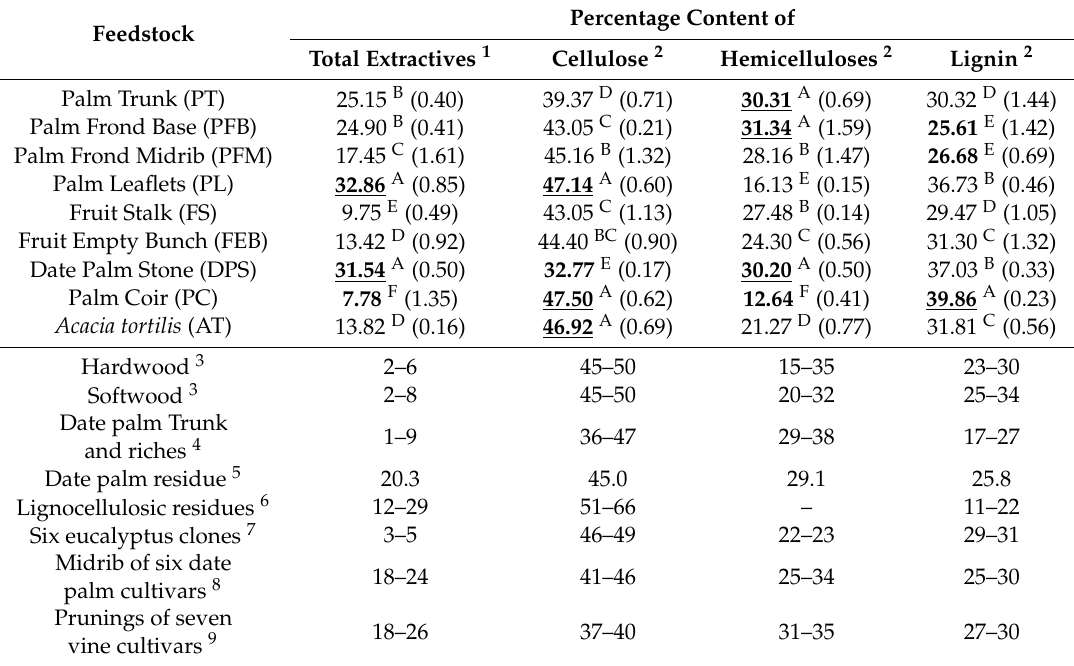
Table 2. Chemical composition (%) *of the date palm residues of Sukkari